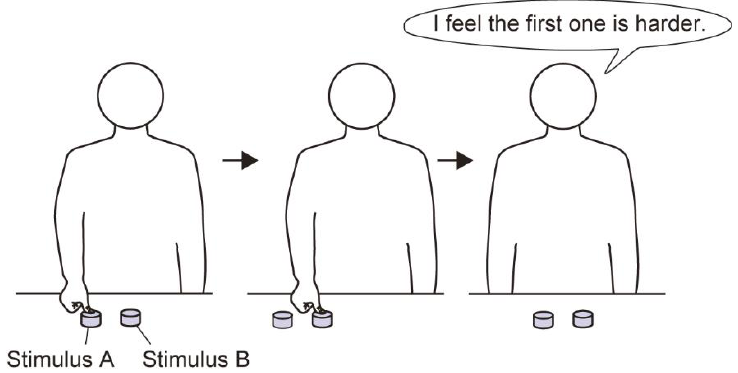
Figure 4. Example of the experimental procedure (discrimination task using stimuli A and B).